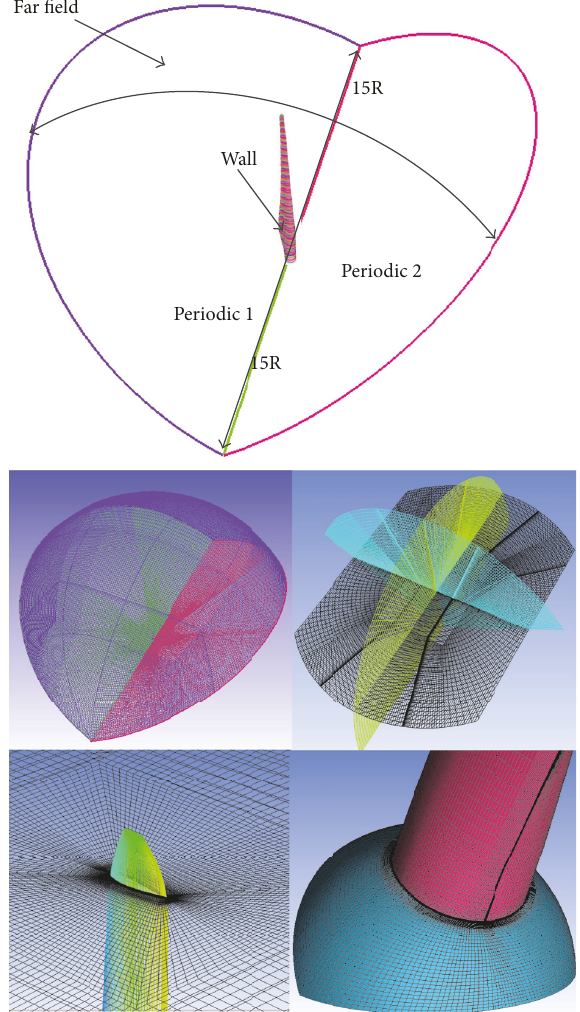
Figure 15: Computing domain and mesh for blade at various